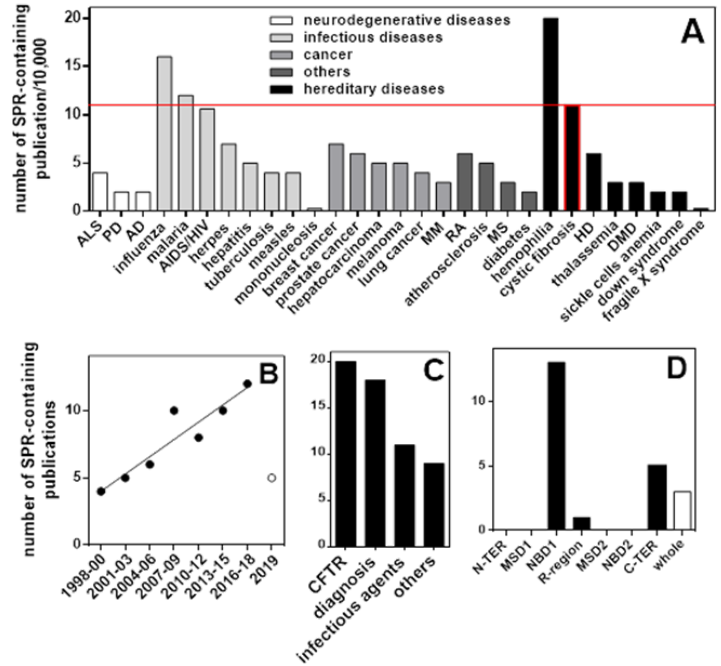
Figure 4. Contribution of SPR to cystic fibrosis (CF). ( A ) Use of SPR in various diseases. ALM: amyotrophic lateral sclerosis; PD: Parkinson disease; AD Alzheimer ’s disease; MM: